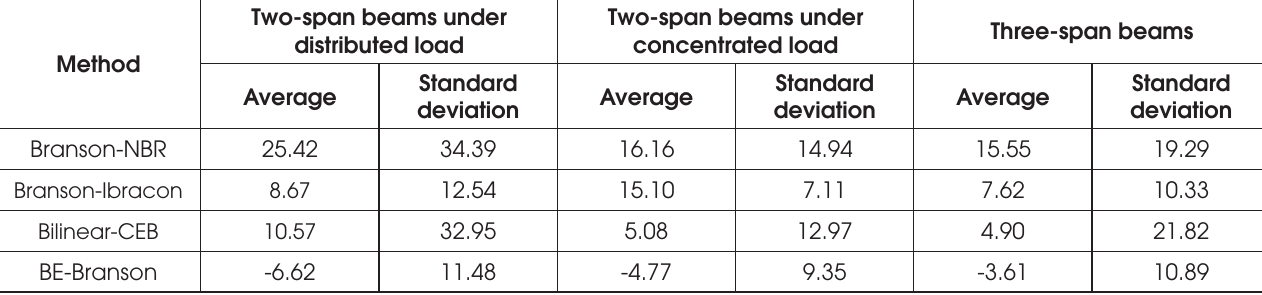
Average of percentage differences (in %) between the final deflections found by the different methods and the reference model, AM, for the two-span beams under distributed load and concentrated load, and for the three-span beams Two-span beams under distributed load Method